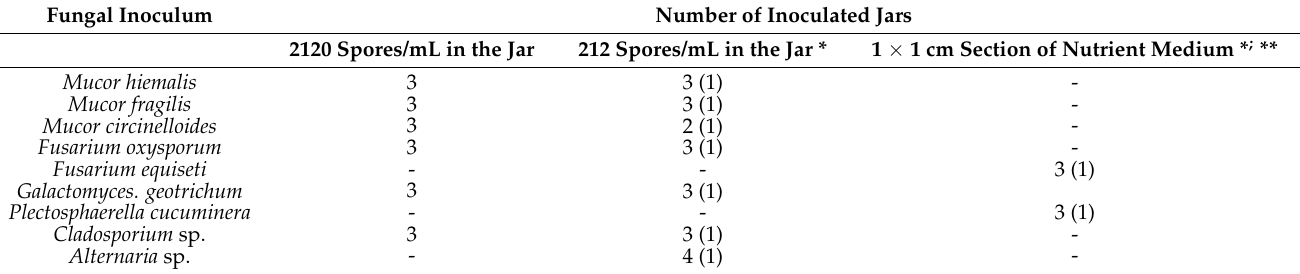
Table 1. Number of ready-to-sell pickle jars inoculated with different fungal spore suspensions with different target spore concentrations in the